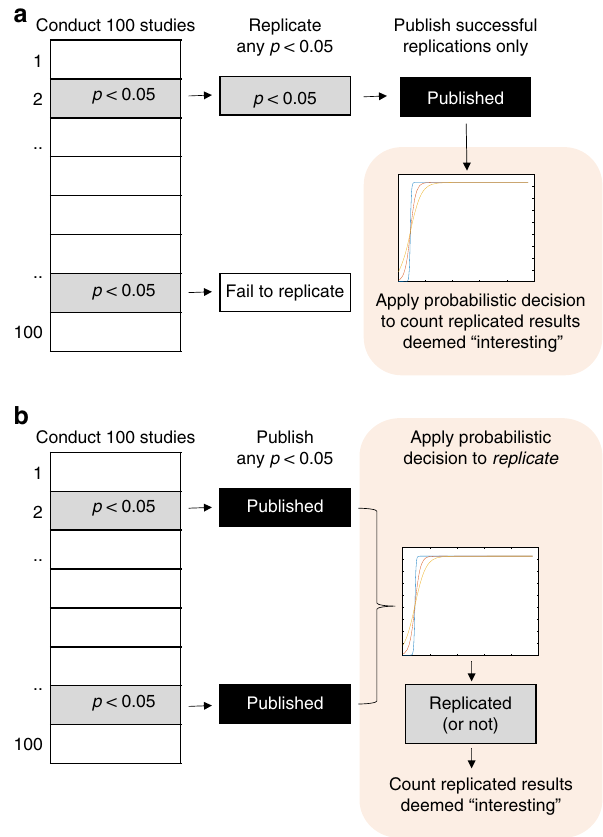
Fig. 1 Comparison of two replication regimes. a Private replication regime: investigators independently conduct 100 studies, and each investigator replicates any signi fi cant result. If replication is successful, both studies are published. The scienti fi c community (represented by orange shading) then determines which of those replicated fi ndings are deemed interesting based on a stochastic decision rule. b Public replication regime: investigators independently conduct 100 studies, and any signi fi cant result is published without replication. The scienti fi c community (orange shading) then determines which of those fi ndings of unknown replicability are deemed interesting, and hence worthy of replication, based on the same stochastic decision